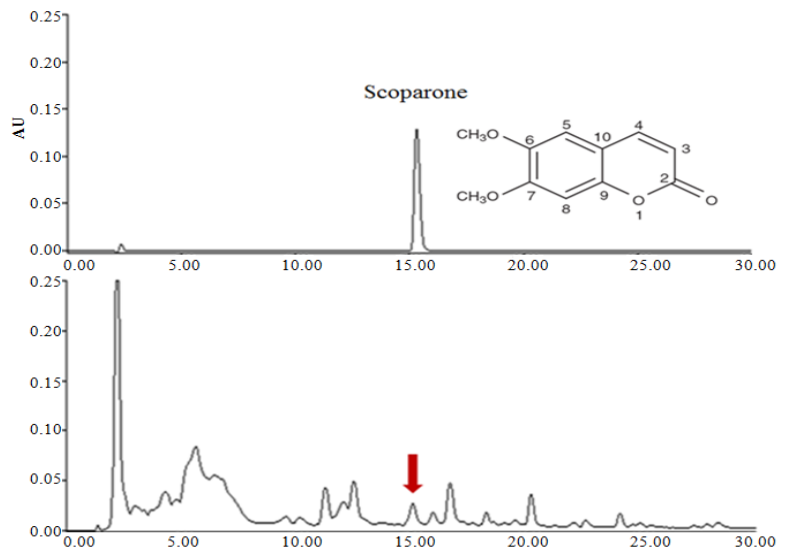
Figure 1. 2-D HPLC chromatograms for standardization of A. capillaris extracts.